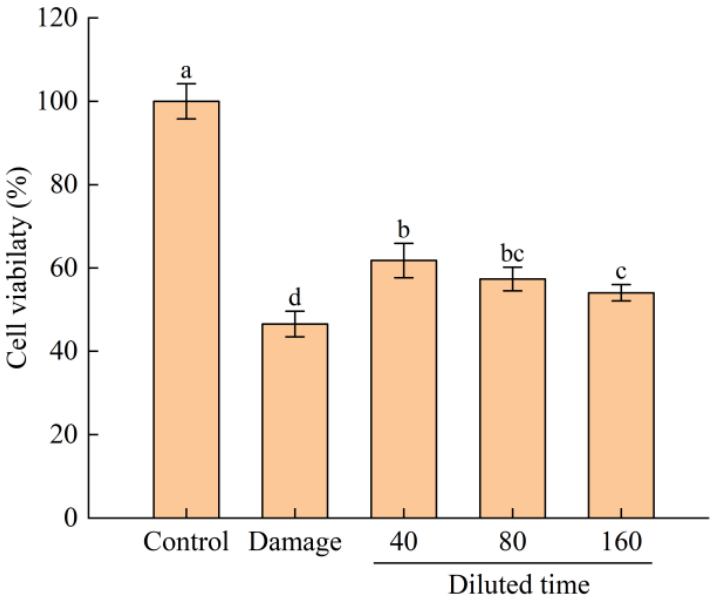
Figure 5. The viabilities of HepG2 cells treated with fermented edible grass of different diluted times and H 2 O 2 . The bars with different letters indicate significant differences ( p < 0.05).